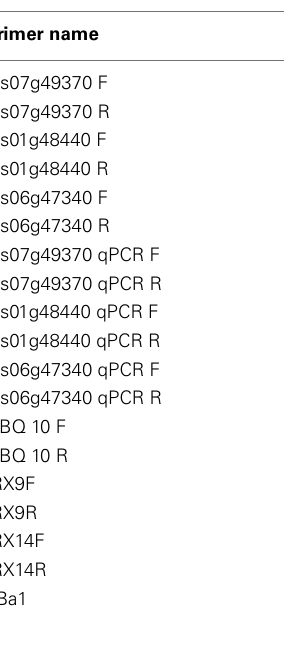
Table 1 | List of primers used for gene cloning and quantitative